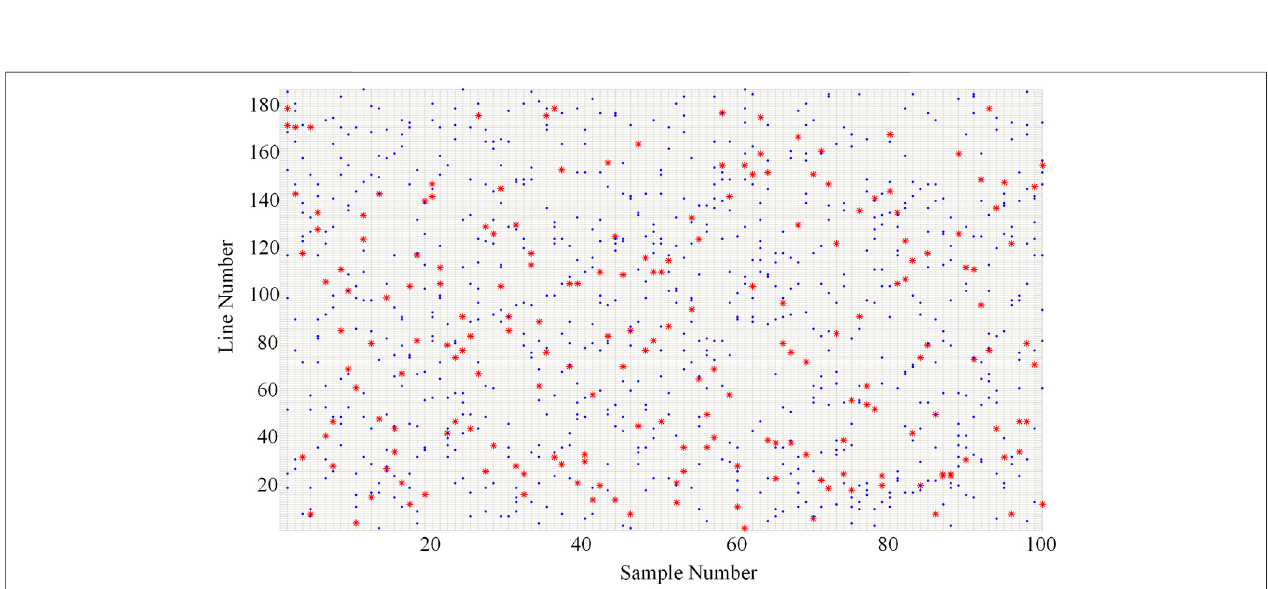
FIGURE 9 | Scatter plot of results of identi fi cation of unlabeled samples.